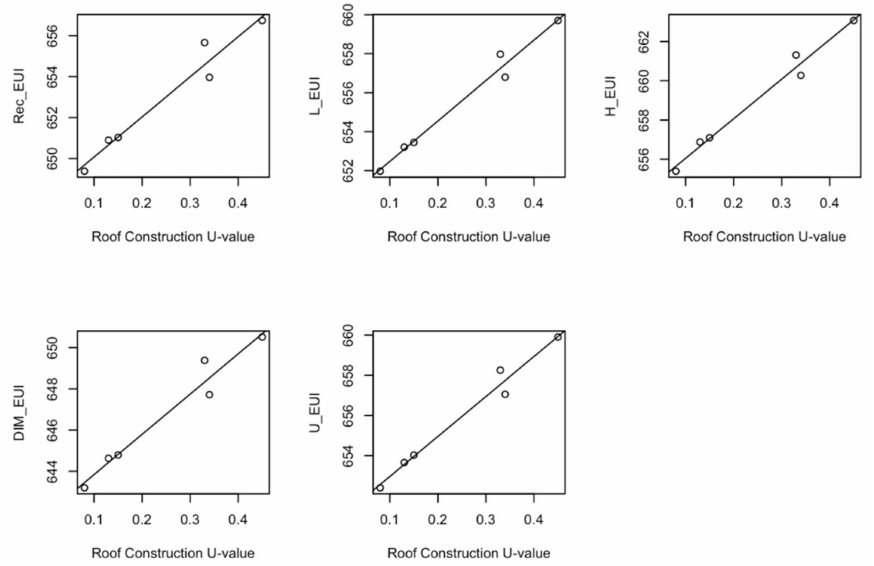
Figure 16. Roof construction fitted line